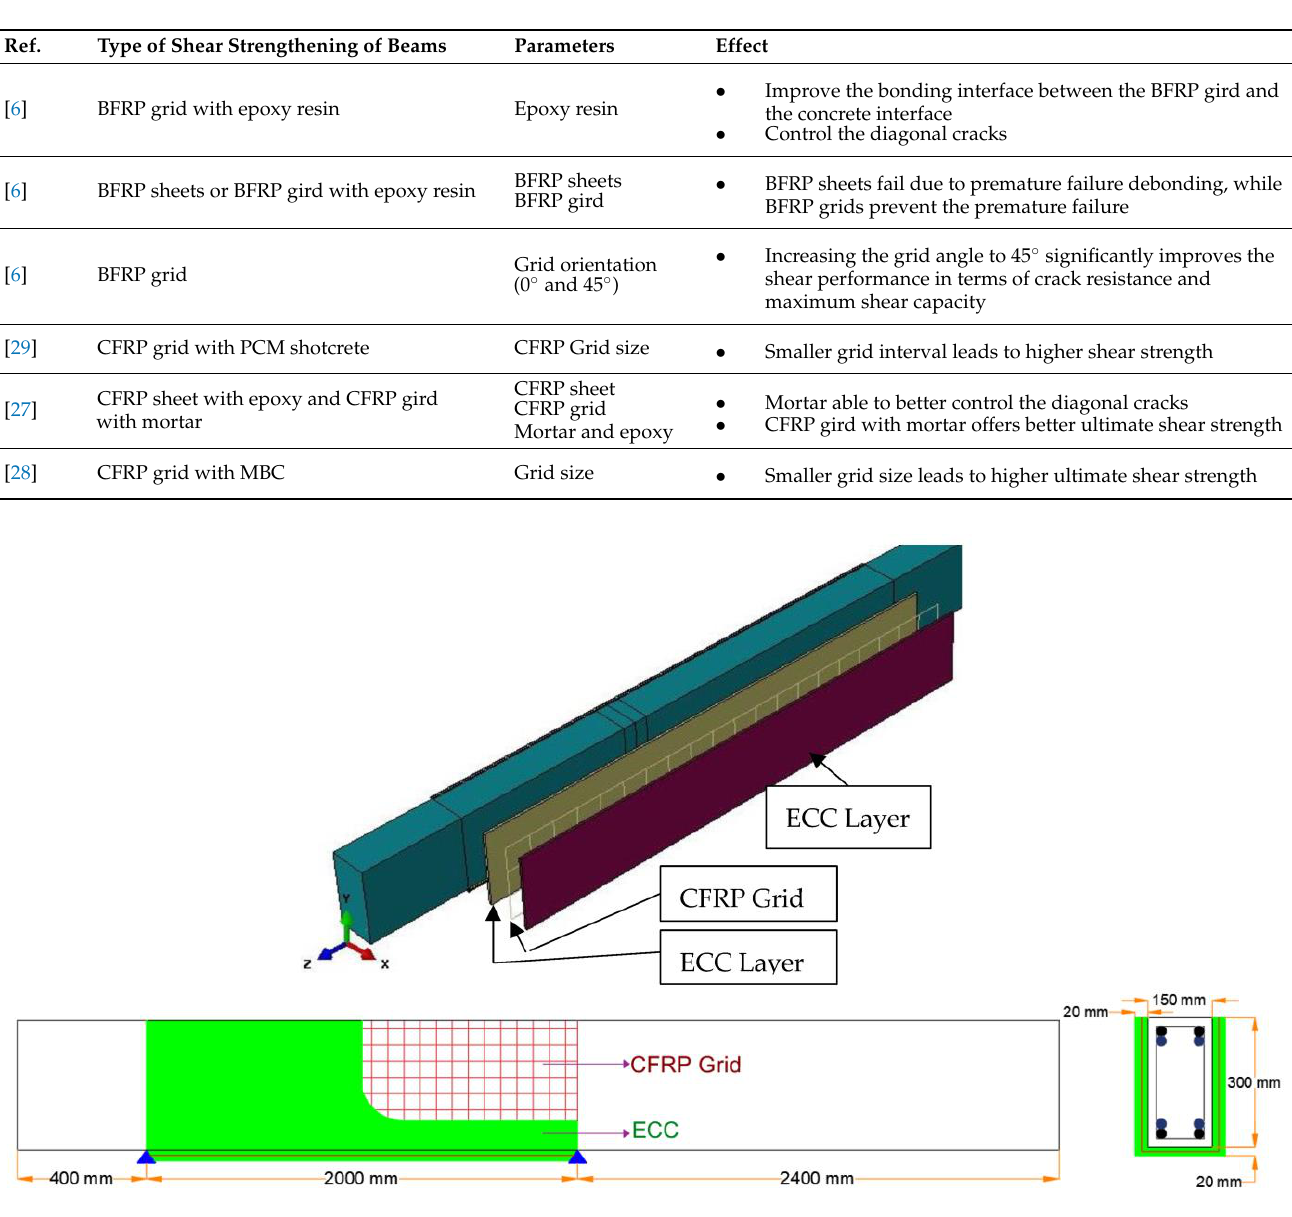
Figure 1. Details of the strengthening beams by CFRP grids with the ECC method.